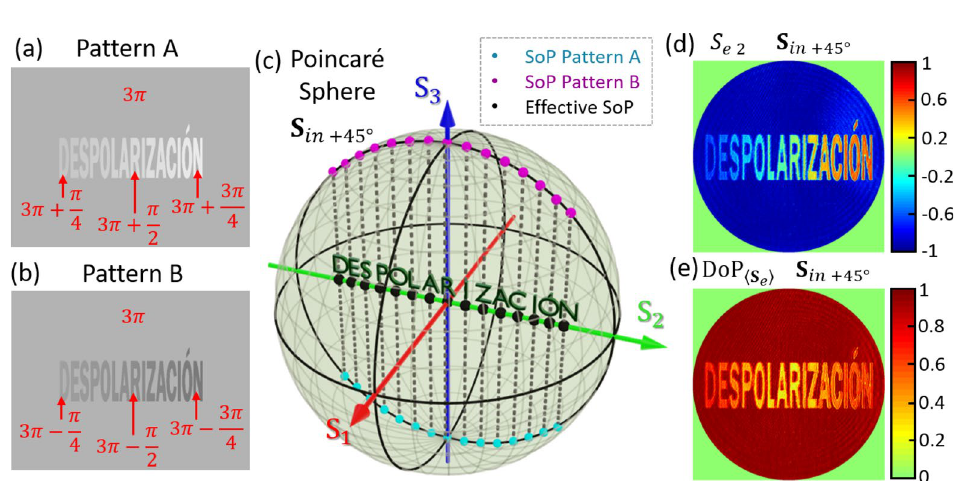
Figure 6. ( a , b ) Phase pattern images encoding a text, with indication of the phase levels, ( c ) theoretical S A , S S B and (cid:31) e (cid:30) Stokes parameters on the Poincaré sphere for each letter and for an input SoP linear at + 45 ◦ , ( d ) experimental effective Stokes parameter S e 2 of the output beam, and ( e ) experimental effective DoP